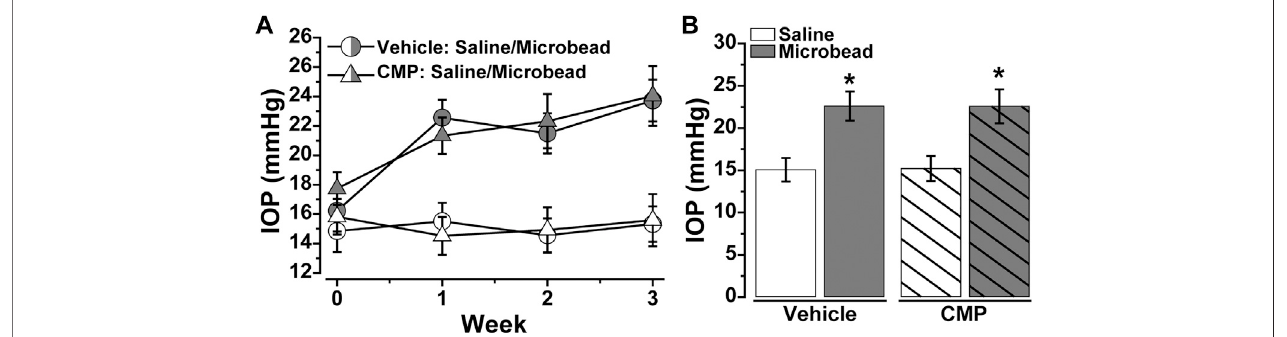
FIGURE 5| Ocular Delivery ofa Mimetic Peptide DoesNot In fl uence IOP. (A) Mean intraocular pressure (IOP) in mice treated with vehicle( ○ ) vs. CMP 03A( Δ ) prior to (day 0) and following (days ≥ 1) a single unilateral injection of polystyrene microbeads or equivalent volume of saline; CMP or vehicle delivery via intravitreal injection occurred on day 10 post-microbead. (B) Microbead injection signi fi cantly elevated IOP for both vehicle (22.59 ± 1.72 vs. 15.06 ± 1.40 mmHg, p < 0.001) and CMP (22.57 ± 2.01 vs. 15.21 ± 1.49 mm Hg, p < 0.001). IOP did not differ between cohorts for either the saline- or microbead-injected eye ( p ≥ 0.70). Statistics: Student ’ s t-test (D). Data (cid:1) mean ± SEM.